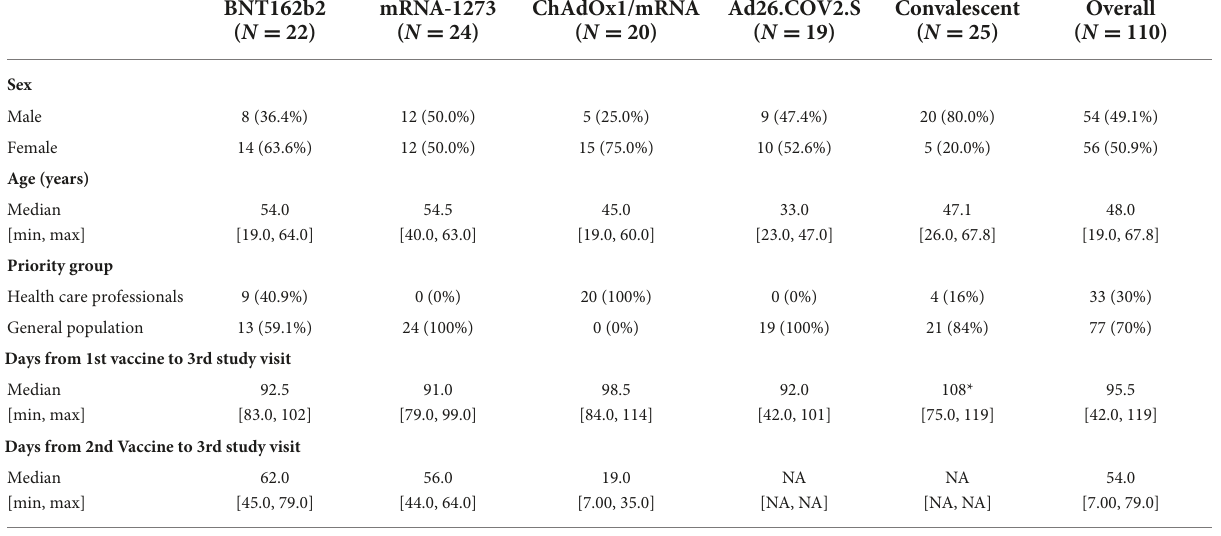
TABLE 1 Demographic characteristics.